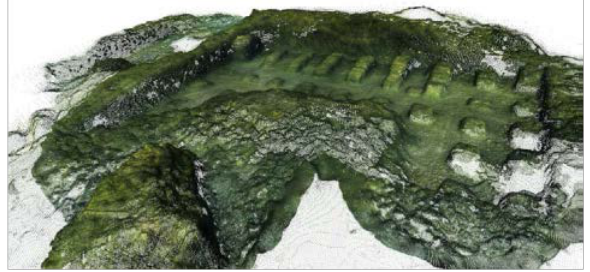
Figure 1. Reconstructed dense point cloud